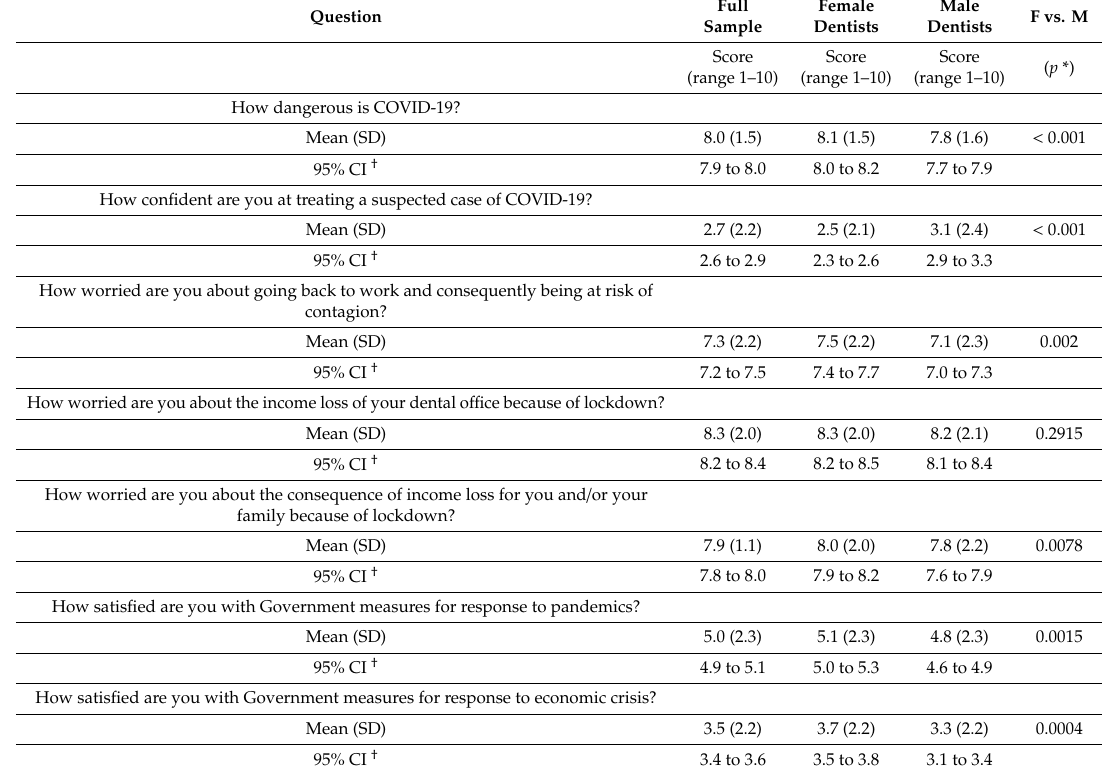
Table 5. Dentists’ attitude score (range 1 to 10) toward COVID-19 in the full sample and in the groups of female and male